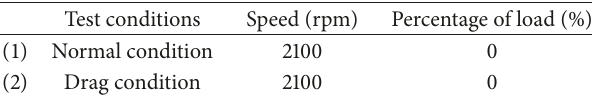
Table 2: Internal combustion engine test conditions.